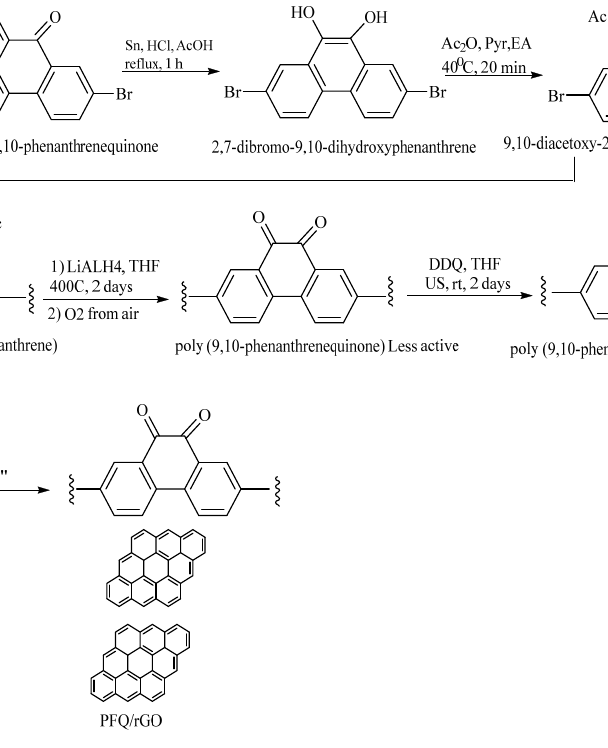
Figure 3. Indirect polymerization of HV polymer.